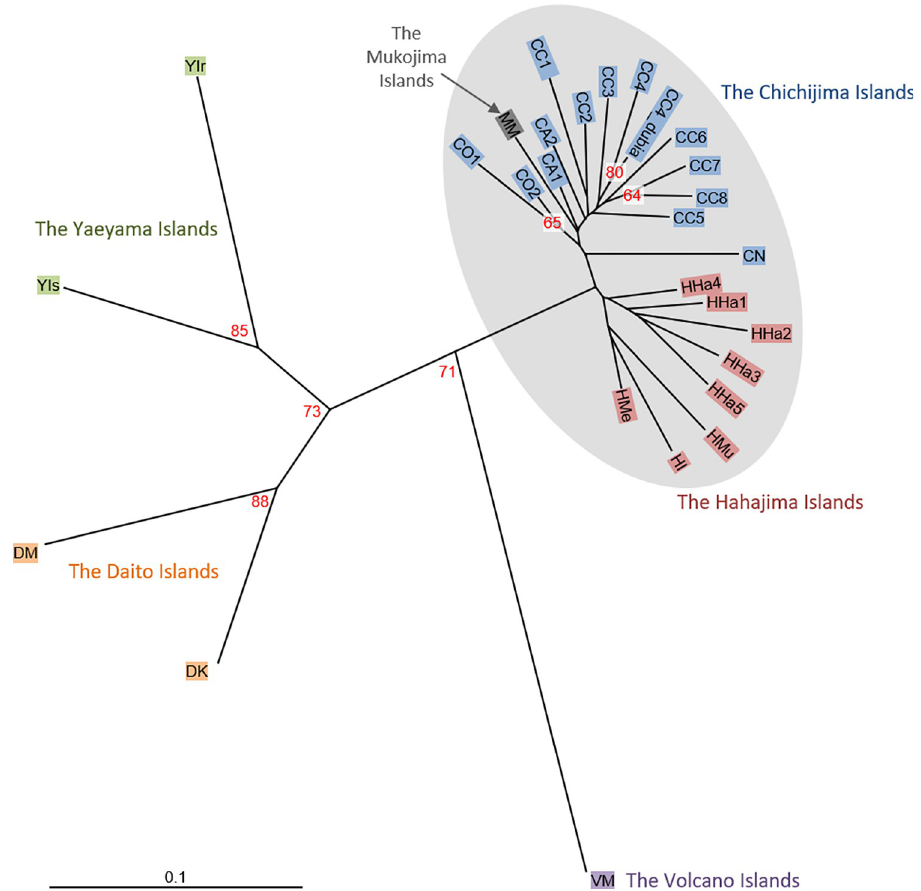
Fig 3. A neighbor-joining dendrogram for 27 Planchonella obovata var. obovata and one P . obovata var. dubia populations based on 11 SSR markers based on genetic distance, D A . Numbers in the internal nodes indicate bootstrap value larger than 50; gray oval, populations in the Bonin